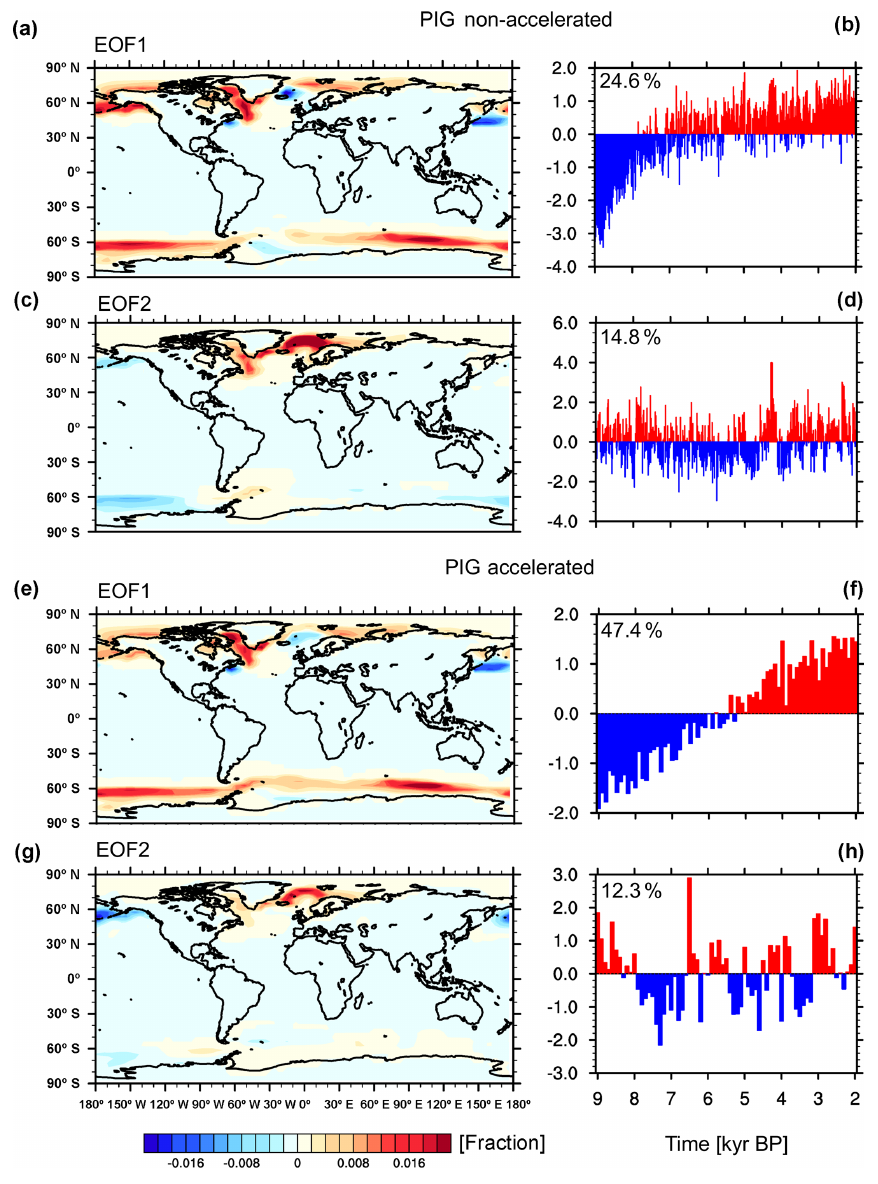
Figure 6. Same as Fig. 5 but for PIG sea-ice